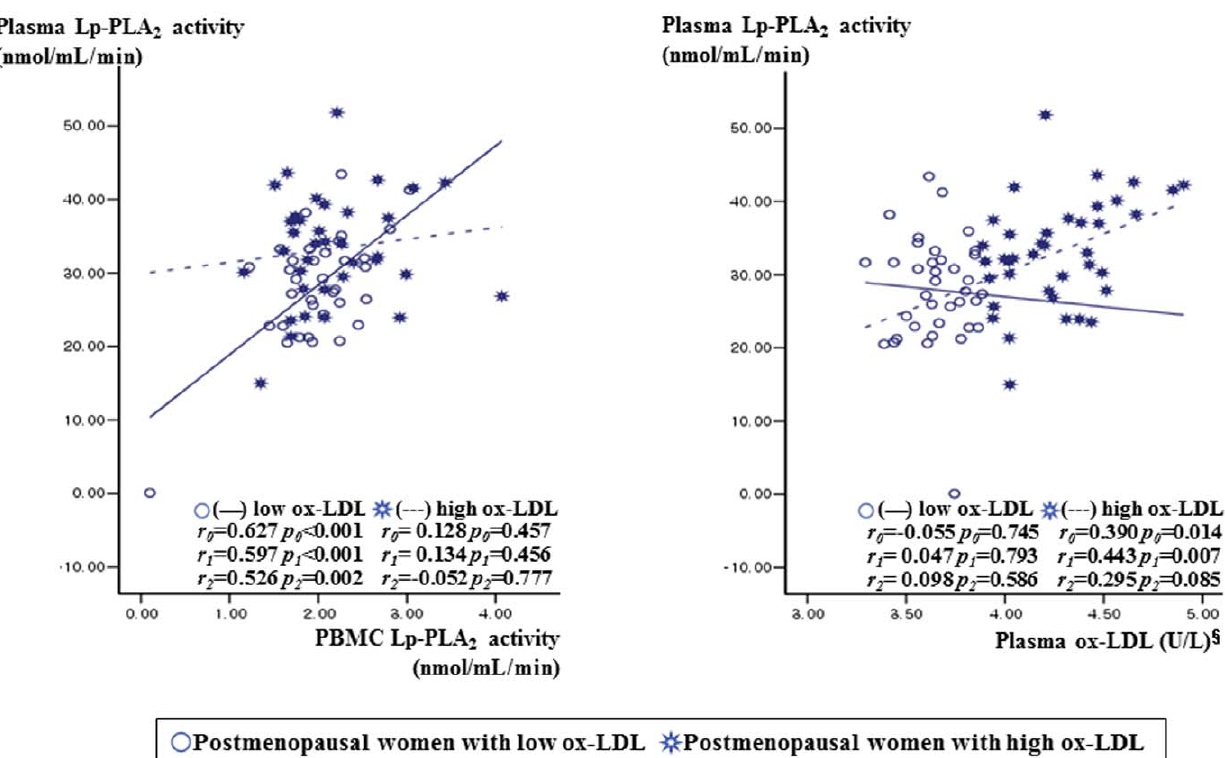
Pearson and partial correlation analysis, r 0 : unadjusted, r 1 : adjusted for age, BMI, and alcohol consumption, *P , 0.05, **P , 0.01, ***P , 0.001,